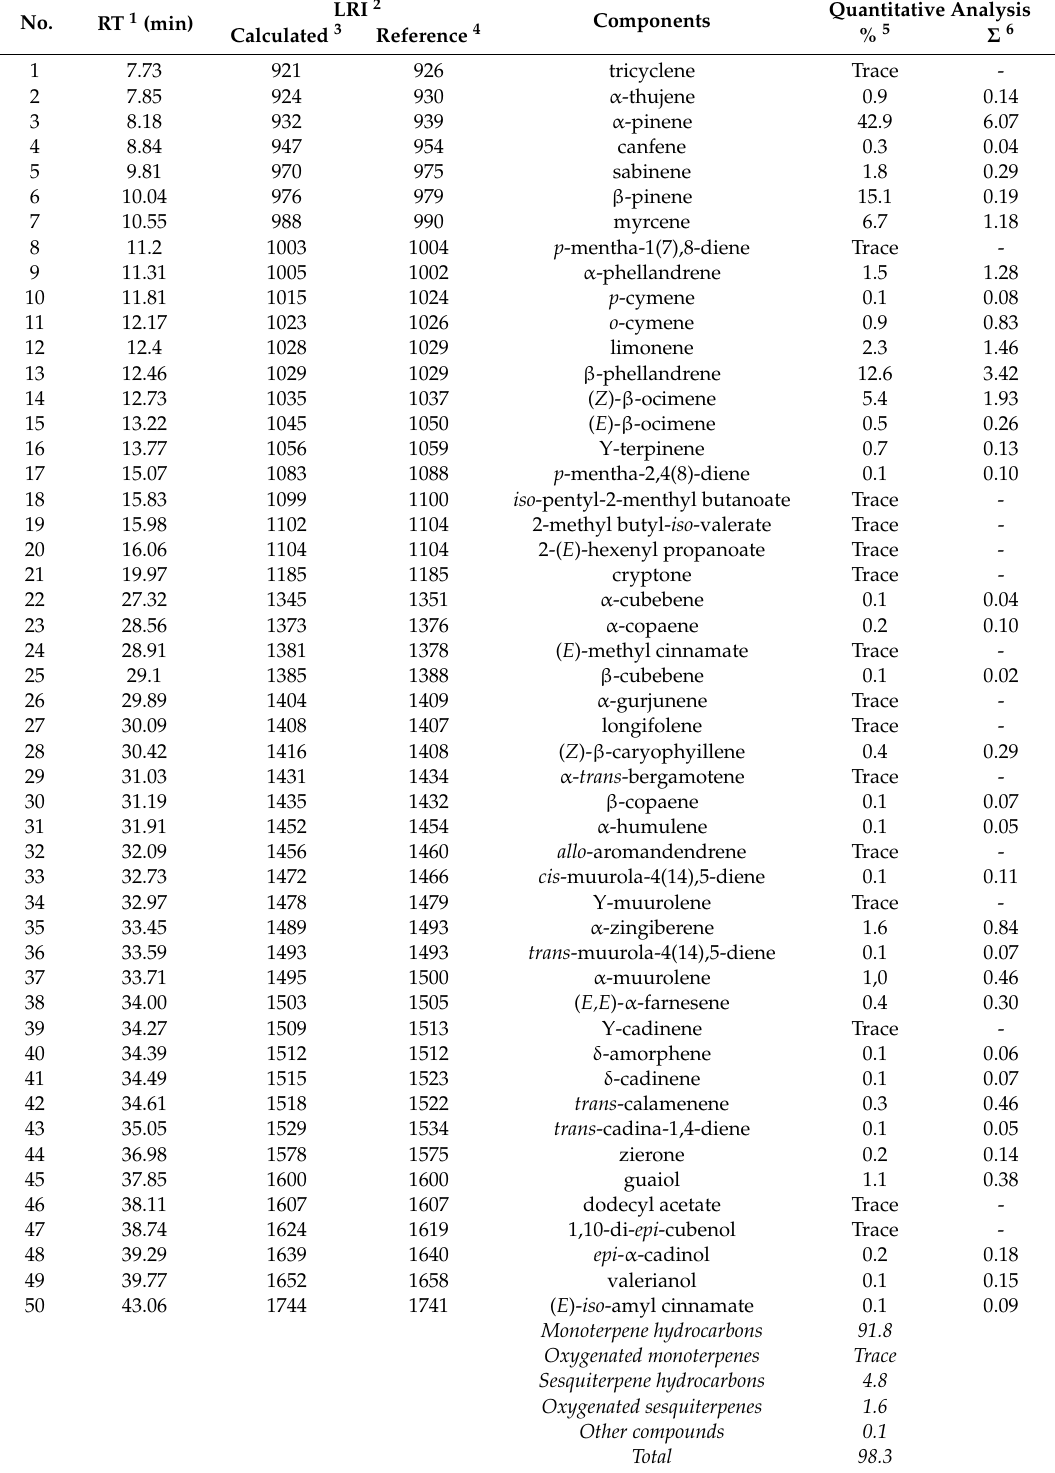
Table 1. Chemical analysis of Dalea mutisii essential oil (EO) using a DB-5ms